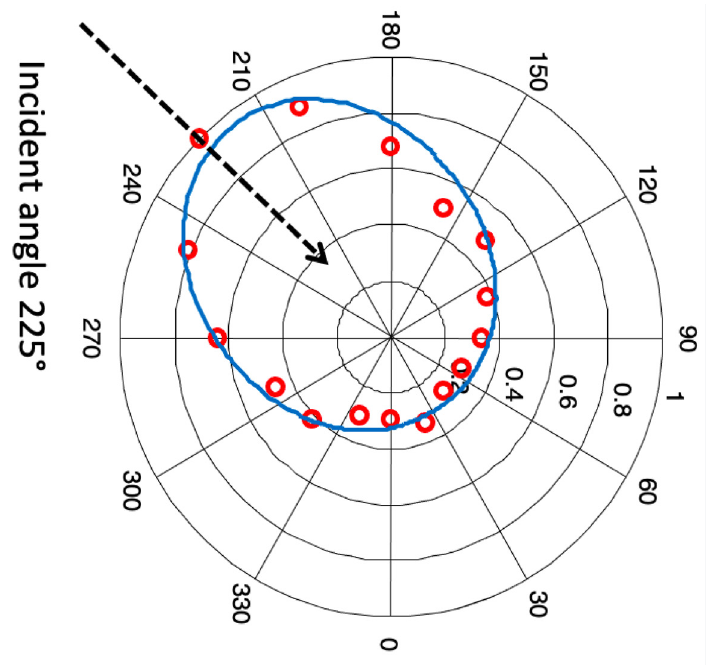
Figure 10. Experimental measurements and numerical predictions of the incident A 0 mode propa- gating in the intact CFRC plate.